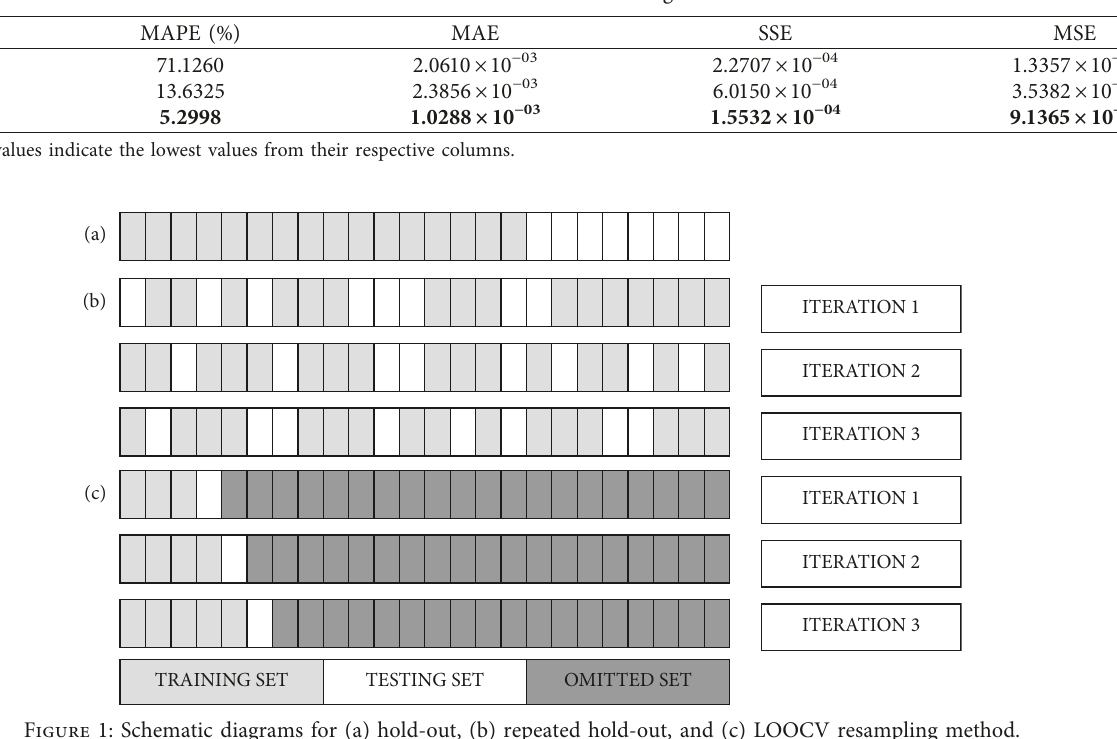
Table 5: Goodness-of-fit measures in fitting of women.